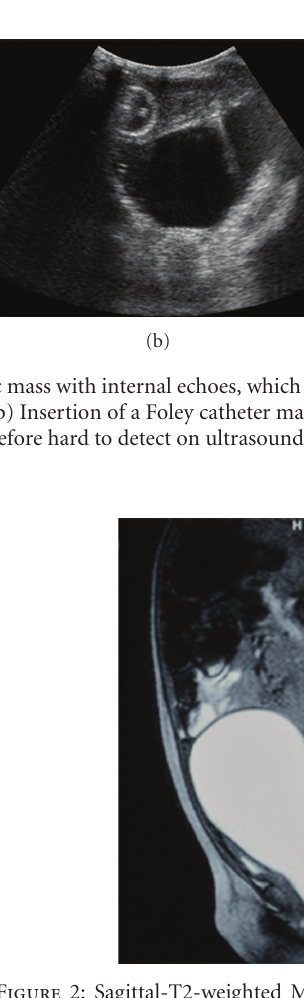
Figure 2: Sagittal-T2-weighted MR image. Marked distention of the uterus and cervix is demonstrated. Note the compressed urinary bladder with little urine in it.